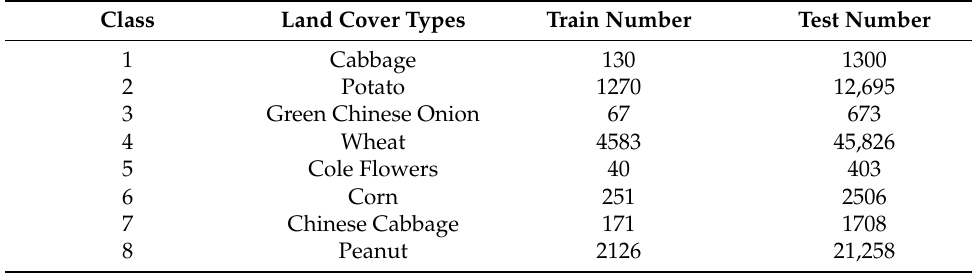
Table 2. Land cover classes with samples number for the GF14